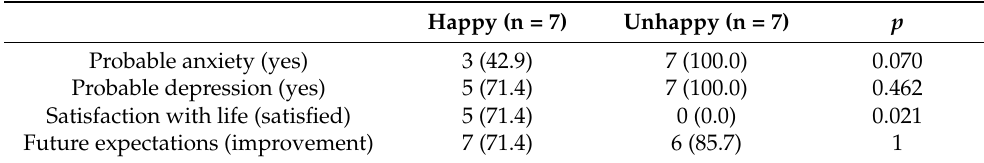
Table 4. Bivariate analysis of the variable happy/unhappy on the happiness scale with respect to the anxiety/depression scale, the satisfaction with life, and the response on future